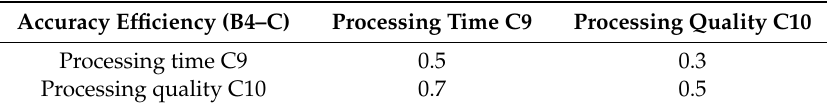
Table 7. Layer judgment matrix (B4–C).